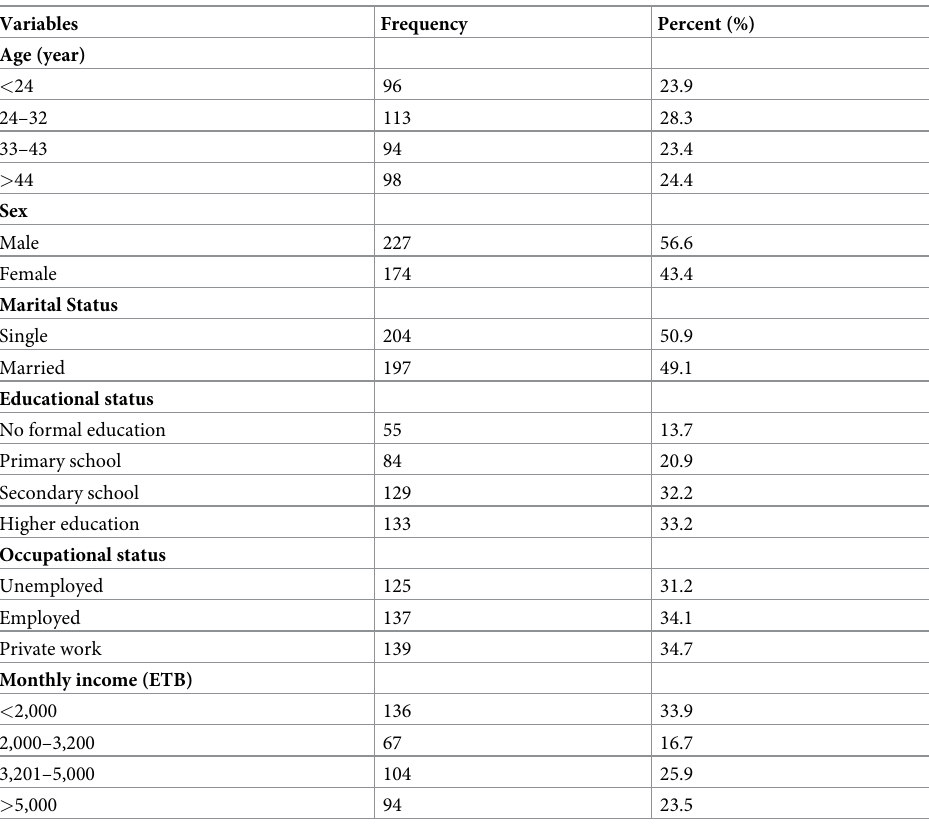
Table 1. Socio-demographic characteristics of adults living in Woreta town, Northwest Ethiopia, 2020 (n =